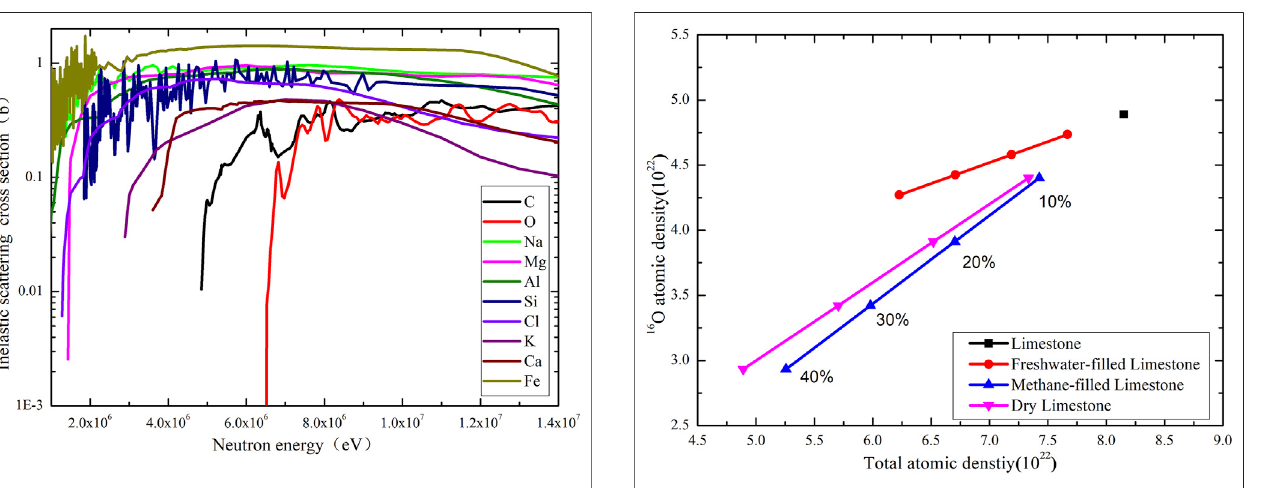
FIGURE 4 | Relationship between 16 O atomic density and total atomic density for various fl uid